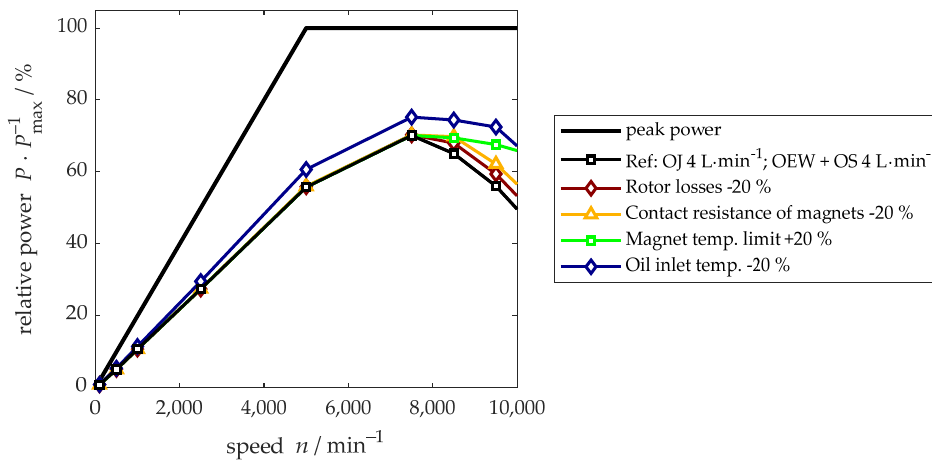
Figure 11. Sensitivity analysis of multiple parameters that effect the thermal performance of the rotor, namely the coolant inlet temperature, the magnet temperature limit, the contact resistance at the magnet surfaces and the iron losses in the rotor with constant volume flow rates in the oil stator jacket (OJ), oil shaft (OS) and oil end winding cooling (OEW).